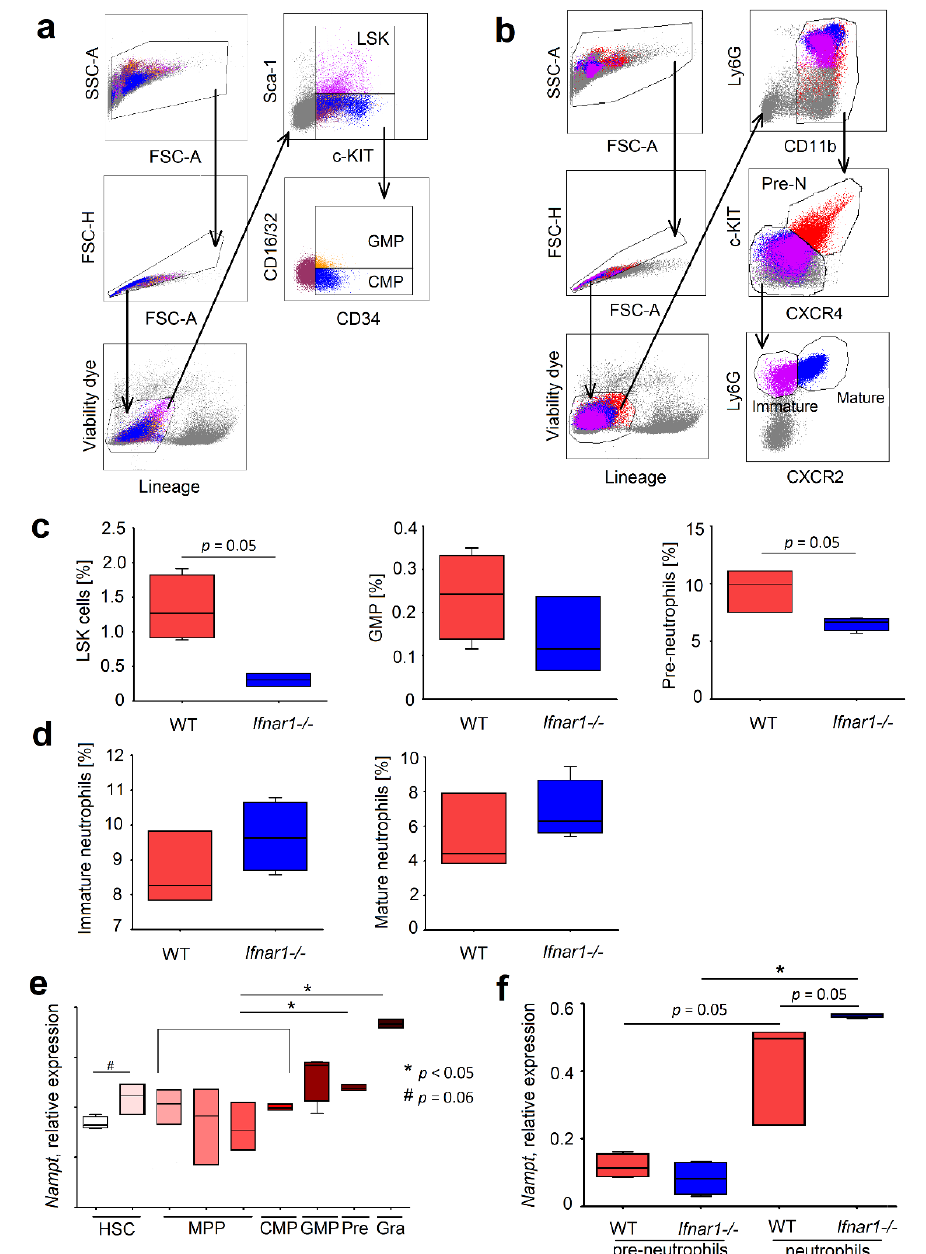
Figure 2. Interferon (IFN) availability influences Nampt expression in neutrophil progenitors and the course of granulopoiesis in mice. ( a ) Gating strategy of LSK cells (single viable Lin − /Sca-1 + /c-KIT + ), common myeloid progenitors (CMP) (single viable Lin - /Sca-1 - /c-KIT + /CD34 + /CD16/32 - ), and granulocyte–monocyte progenitors (GMPs) (single viable Lin - /Sca-1 - /c-KIT + /CD34 + /CD16/32 + ); ( b ) Gating strategy of pre-neutrophils (single viable CD3e - /CD45R - /NK-1.1 - /CD11b + /c-KIT + /CXCR4 + cells), immature neutrophils (single viable CD3e - /CD45R - /NK-1.1 - /CD11b + /c-KIT - /CXCR4 - /Ly6G + /CXCR2 - cells), and mature neutrophils (single viable CD3e - /CD45R - /NK-1.1 - /CD11b + /c-KIT - /CXCR4 - /Ly6G + /CXCR2 + cells); ( c,d ) Neutrophil progenitors in different stages of differentiation presented as a percentage from all viable cells from bone marrow of WT and Ifnar1 -/- mice ; ( e ) Expression of Nampt gene in neutrophil progenitors in different stages of maturation; ( f ) Expression of Nampt gene in pre- neutrophils and neutrophils from bone marrow of WT and Ifnar1 -/- mice. n = 3–4 mice per group. Data are presented as median, 25th and 75th percentiles, and minimal and maximal values. * p < 0.05.